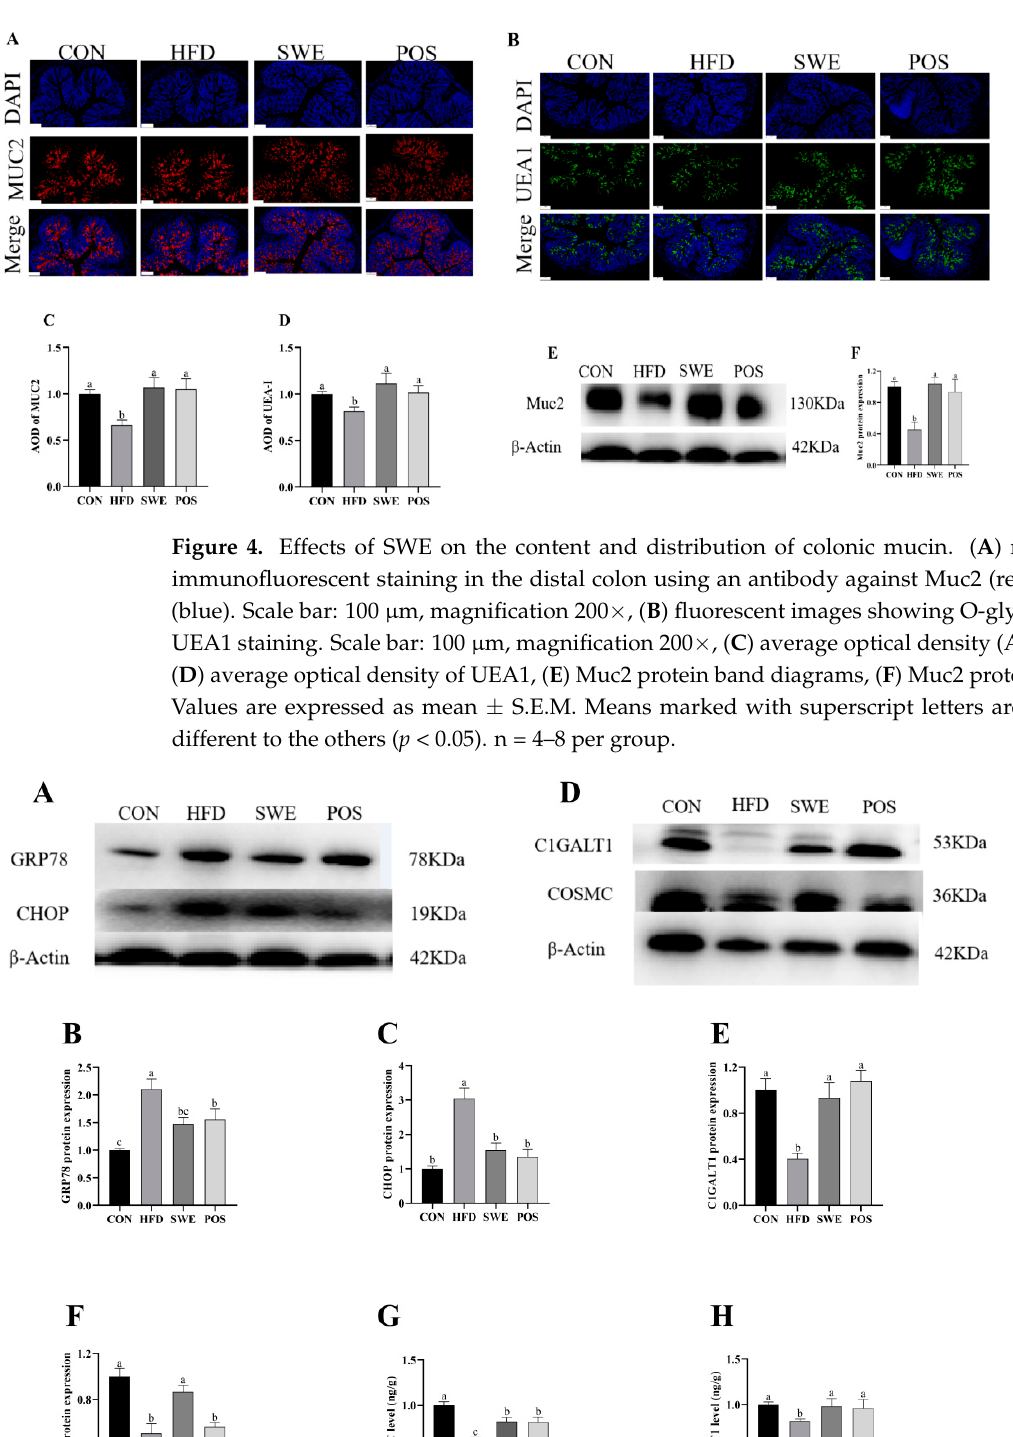
8 of 15 Figure 3. Effects of SWE on colonic mucus thickness and number of goblet cells in HFD-fed mice. ( A ) representative AB/PAS-stained distal colon sections showing mucus layer thickness and goblet cells within the colon tissue, scale bar: 50 μ m, ( B ) manually measured colonic mucus layer thickness, ( C ) number of goblet cells per crypt (5–8 sections per animal). Values are expressed as mean ± S.E.M. Data with different superscript letters are significantly different ( p < 0.05). n = 4–6 per group. 3.5. Effects of SWE on the Production and Distribution of Colonic Mucin Immunofluorescent staining revealed that the average optical degree (AOD) of Muc2 in the HFD group was decreased. In contrast, an increase in AOD of Muc2 in the other groups was observed (Figure 4A,B). We then tested whether the increase of Muc2 secretion was accompanied by appreciable changes in O-glycosylation. We used lectin